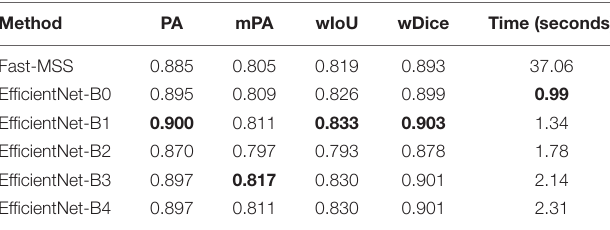
TABLE 3 | Classification scores of each method for producing dense labels compared against ground-truth.